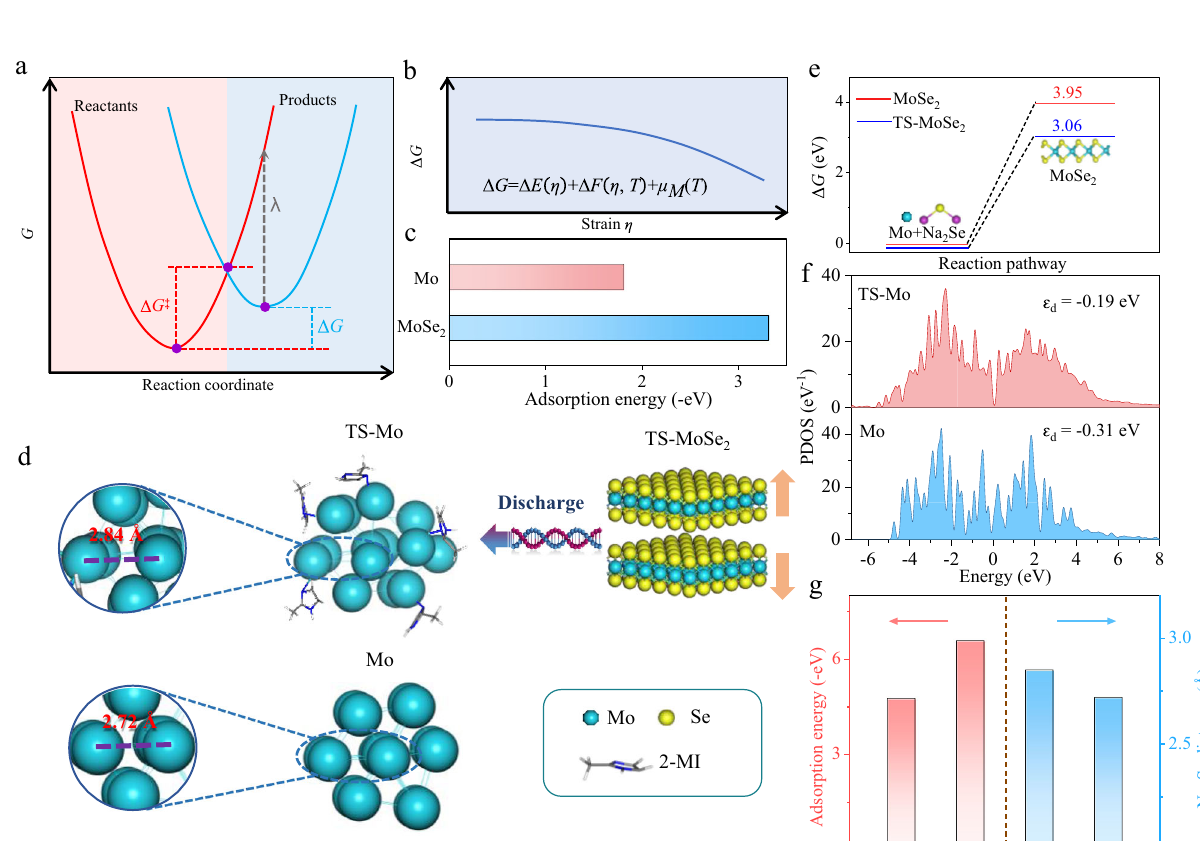
Fig.1|Theoreticalcalculations.a Schematicdiagramoftuningreactantstomake the redox reactionmore energetically favorable. b Thevariationof Δ G associated withtheredoxreactionunderepitaxialstrain( η )ataconstanttemperature. c